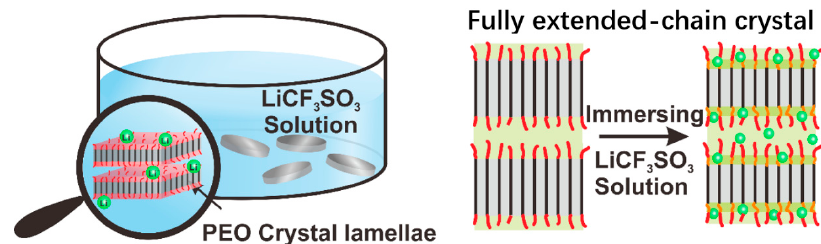
Figure 1. Schematic of the immersion process and Li + distribution. The orange lines and red lines denote the PEO amorphous chain segments and chain ends, respectively. The black lines denote the crystalline PEO chains, and the green balls denote the Li +